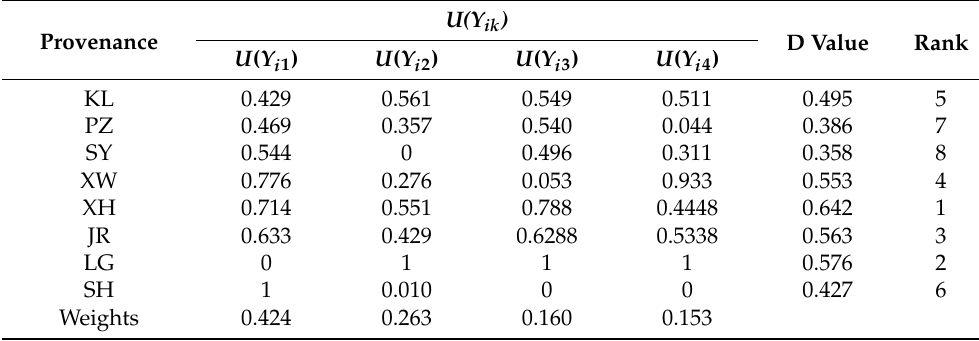
Table 9. The function value of the comprehensive indexes ( U ( Y ik )), weight ( W k ), and the comprehen- sive evaluation value (D) of the different provenances under mild drought stress.